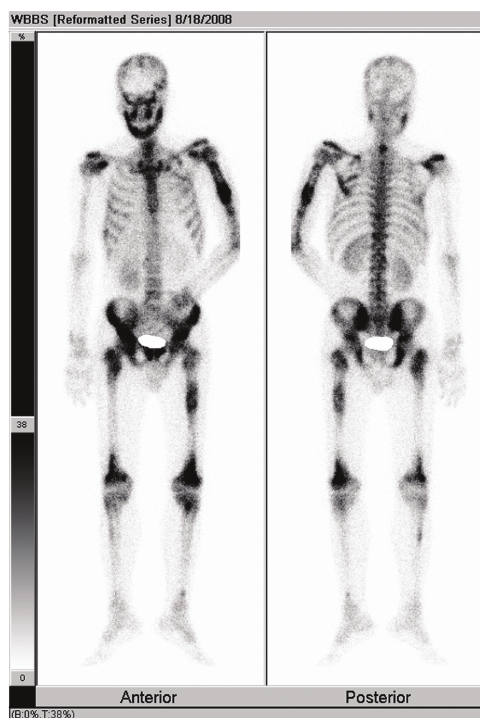
Figure 1: Tc-99m MDP WBBS of the first admission found multiple lesions with intensive radioactive accumulation in skull, mandible, left humerus, scapulas, ribs, vertebras, pelvis, femurs, and